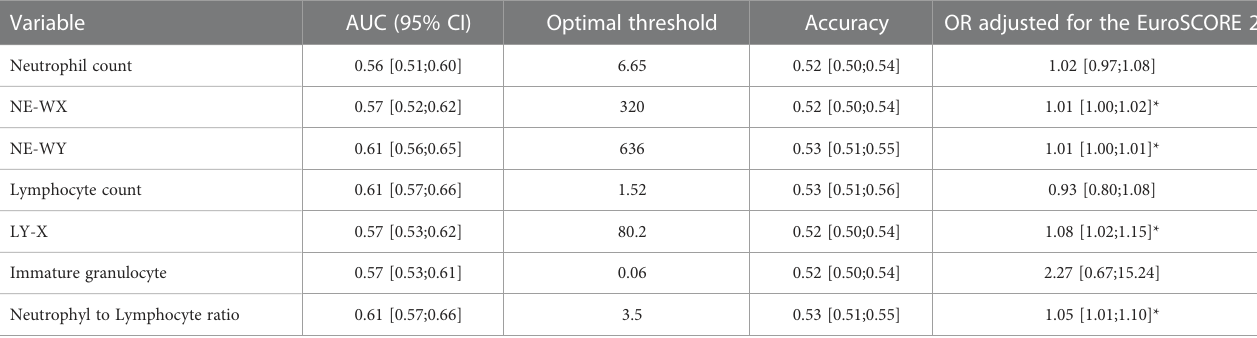
OR, Odd ratio. For adjusted OR, each parameter was individually adjust on the EuroSCORE 2. Accuracy is given for the optimal threshold. *p